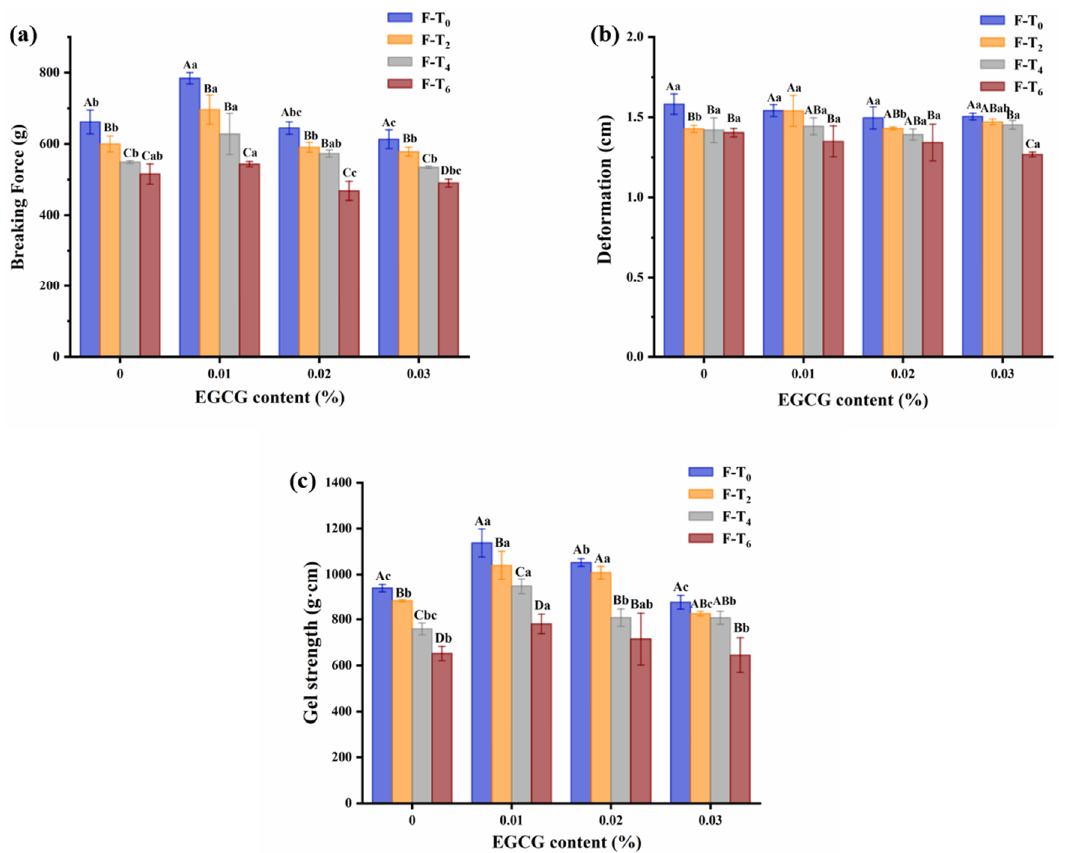
Figure 2. Changes in breaking force ( a ), deformation ( b ), and gel strength ( c ) of surimi gels treated with different content EGCG during F-T cycles. Uppercase letters indicate significant difference ( p < 0.05) between different F-T cycle, lowercase letters indicate the difference between gels with different EGCG content ( p < 0.05). F-T 0 : the zeroth freeze-thaw cycle; F-T 2 : the second freeze-thaw cycle; F-T 4 : the fourth freeze-thaw cycle; F-T 6 : the sixth freeze-thaw